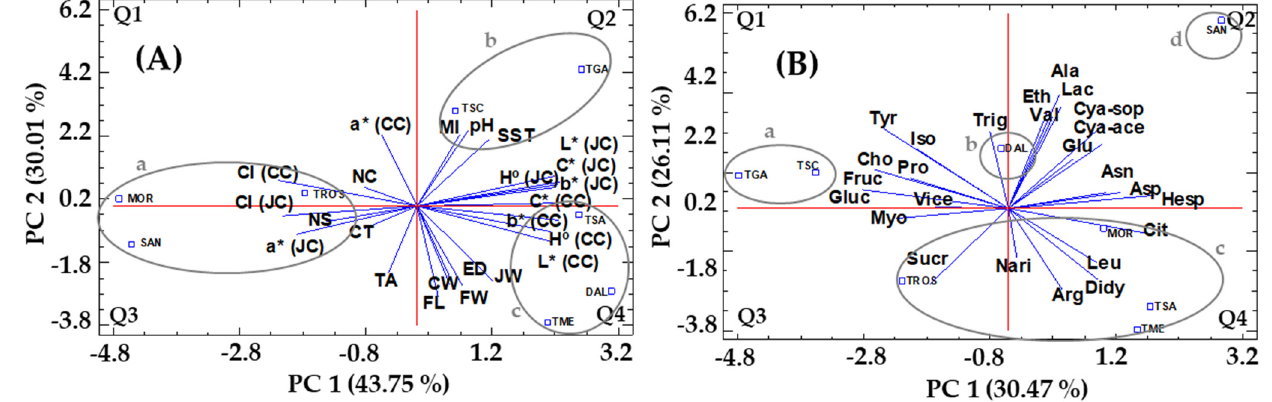
Figure 4. Principal component analysis of morphological and quality parameters ( A ) and individual amino acids, organic acids, sugars and phenolic compounds ( B ) in juice of eight blood orange vari-